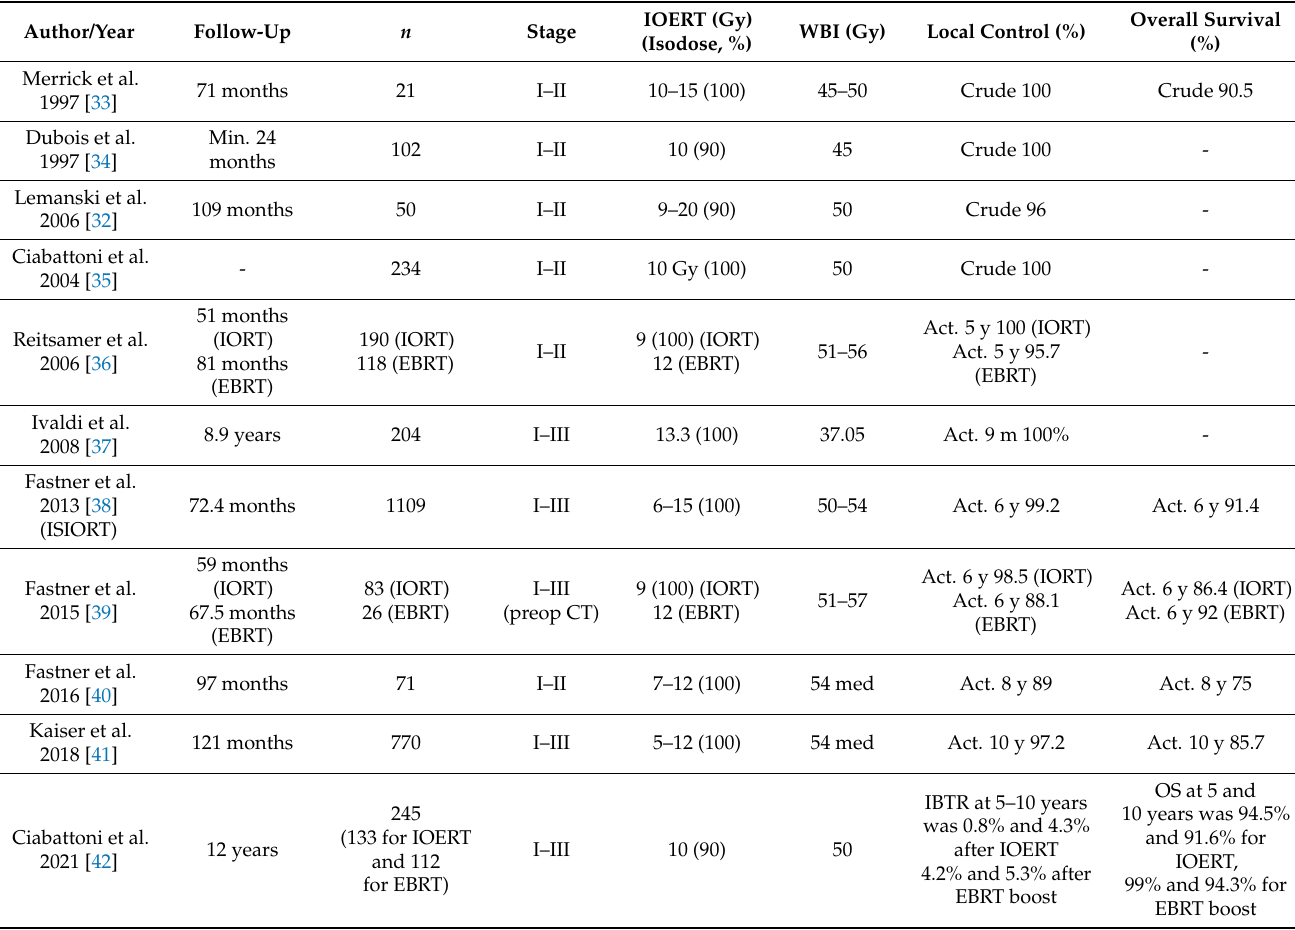
Table 7. Main studies on the treatment with IOERT-boost followed by whole breast